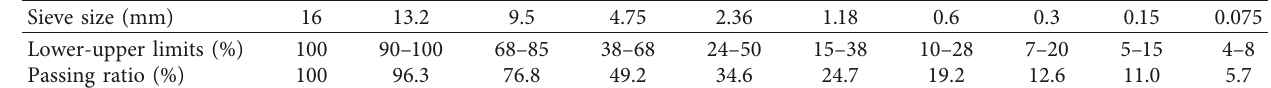
Table 7: Gradation of the RH-WMA.